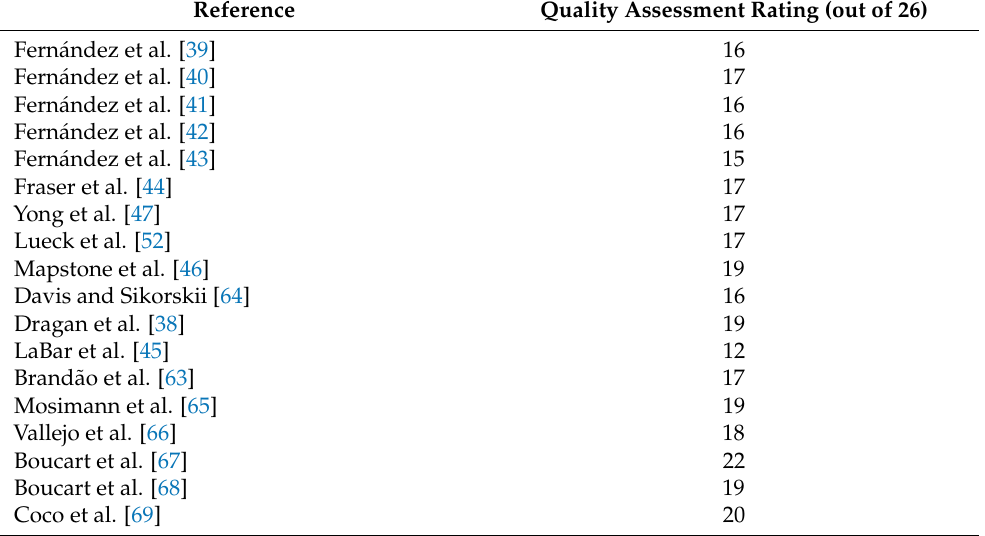
Table 1. Quality assessment ratings using our modified version of the Downs and Black [86] checklist for each paper included in the literature